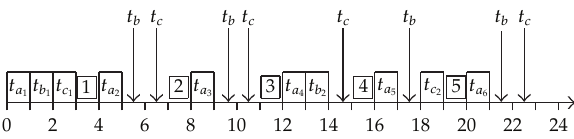
Figure 1: Several scheduling possibilities of task t d (cid:3) Example 2.5 (cid:4)